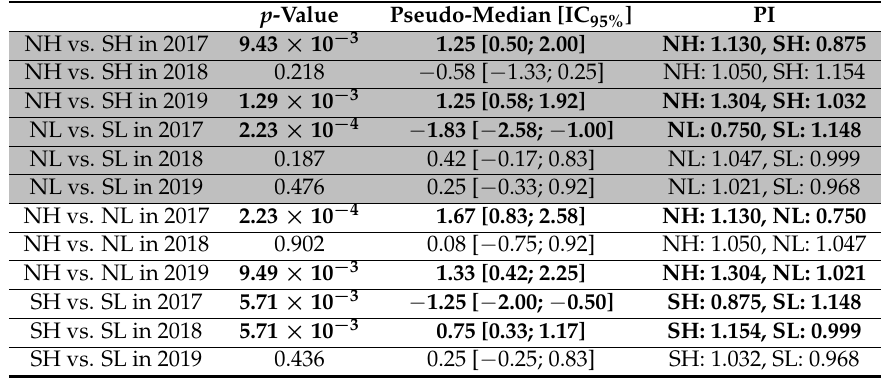
Table 3. Wilcoxon Signed Rank bilateral tests for paired samples on the inter-slope and inter-altitude levels. p -values have been corrected by the FDR method and are shown in Figure 3. The pseudo-medians of the daily activity hours differences and their 95% confidence interval as well as the associated persistence indices (PI) are also presented. Significant differences are in bold.